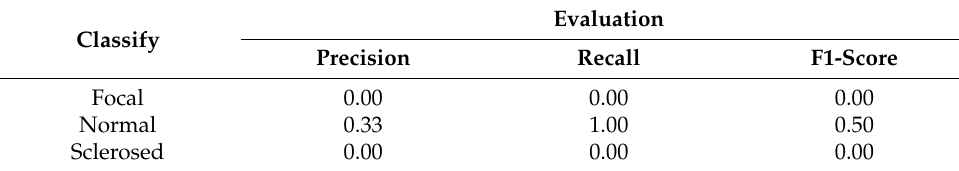
Table 6. Classification of Resnet101V2. Table 5. Classification of EfficientNetL2.